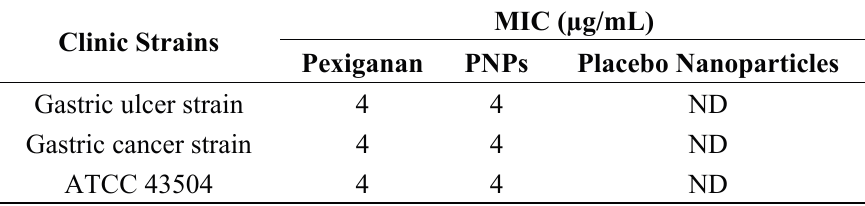
Table 1. MICs of pexiganan and PNPs for a H. pylori gastric ulcer strain, gastric cancer strain and standard strain (ATCC